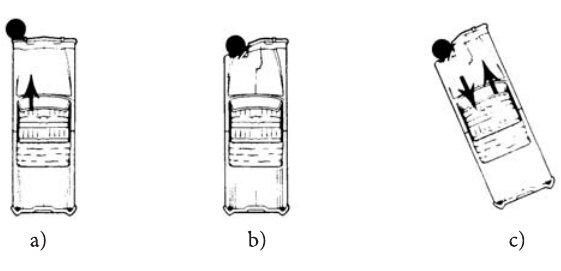
Fig. 1. Central collision with a tree